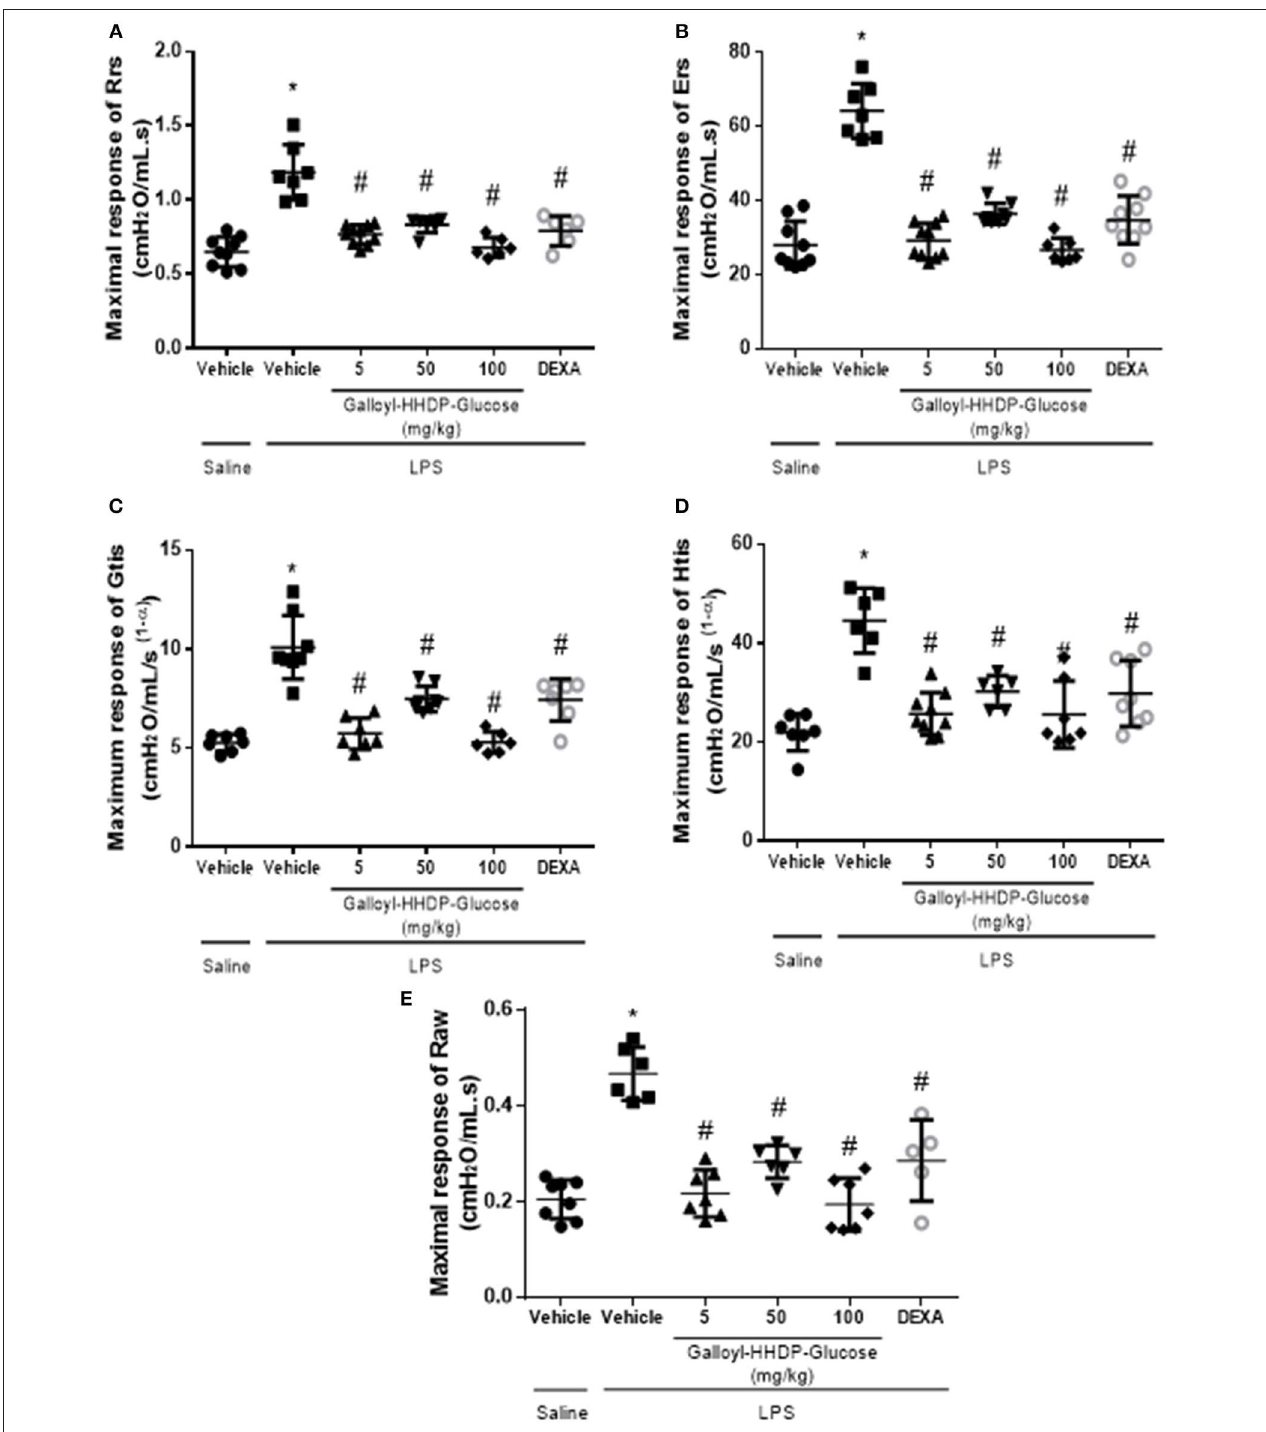
FIGURE 7 | Efficacy of galloyl-HHDP-glucose treatments in reducing respiratory system and lung tissue elastance in lipopolysaccharide (LPS)-induced ALI mice. The respiratory system resistance (Rrs) and elastance (Ers), tissue damping (Gtis) and elastance (Htis), and airway resistance (Raw) (A–E) . The mice received different doses of galloyl-HHDP-glucose (5, 50, and 100 mg/kg) 6h after intra-tracheal instillation of LPS. The values are presented as mean and SD. Significances were calculated by One-way ANOVA followed by Tukey test. Significances were calculated by One-way ANOVA followed by Tukey test analysis of the groups vs. saline-injected non-treated mice (* p < 0.05) and vs. lipopolysaccharide (LPS)-installed non-treated mice ( # p < 0.05).